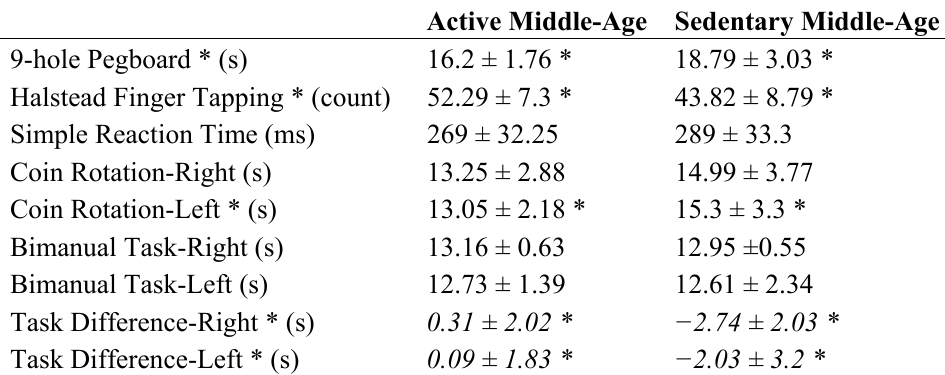
Table 3. Motor Performance Measures—Mean ±